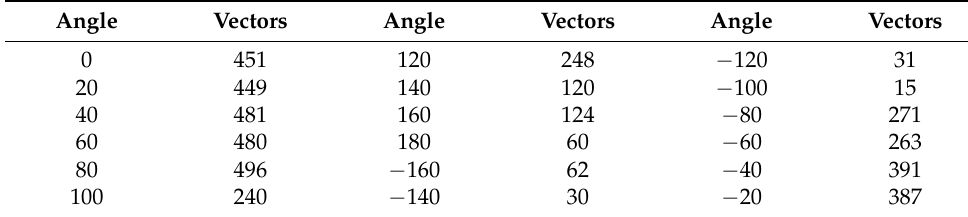
Table 5. Selected Vectors for the SVM-10L Scheme.